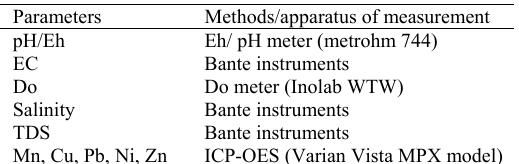
Table 2: Summary of methods and apparatus for determining various parameters